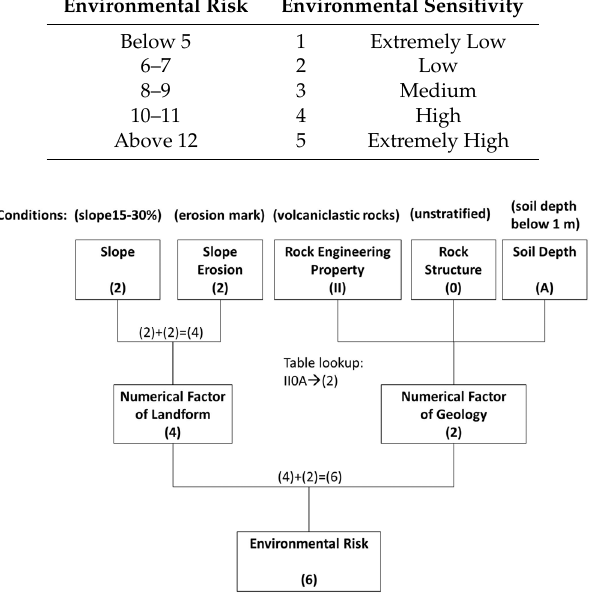
Figure 2. Example of the environmental risk calculation.